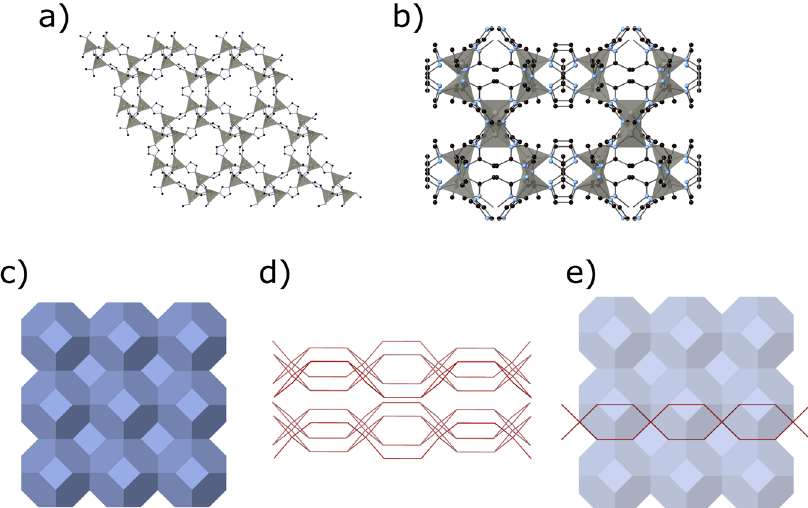
Fig. 1 Graphical representations of the ZIF-8 and ZIF-L crystal structures. The structures of a ZIF-8 and b ZIF-L. Black spheres represent carbon, blue represent nitrogen and grey tetrahedra represent ZnN 4 . Hydrogen atoms omitted for clarity and the underlying topological units for c ZIF-8, d ZIF-L and e the two superimposed at scale. Produced using Crystal maker X 10.4.6 using CIF fi les from refs. 35,43